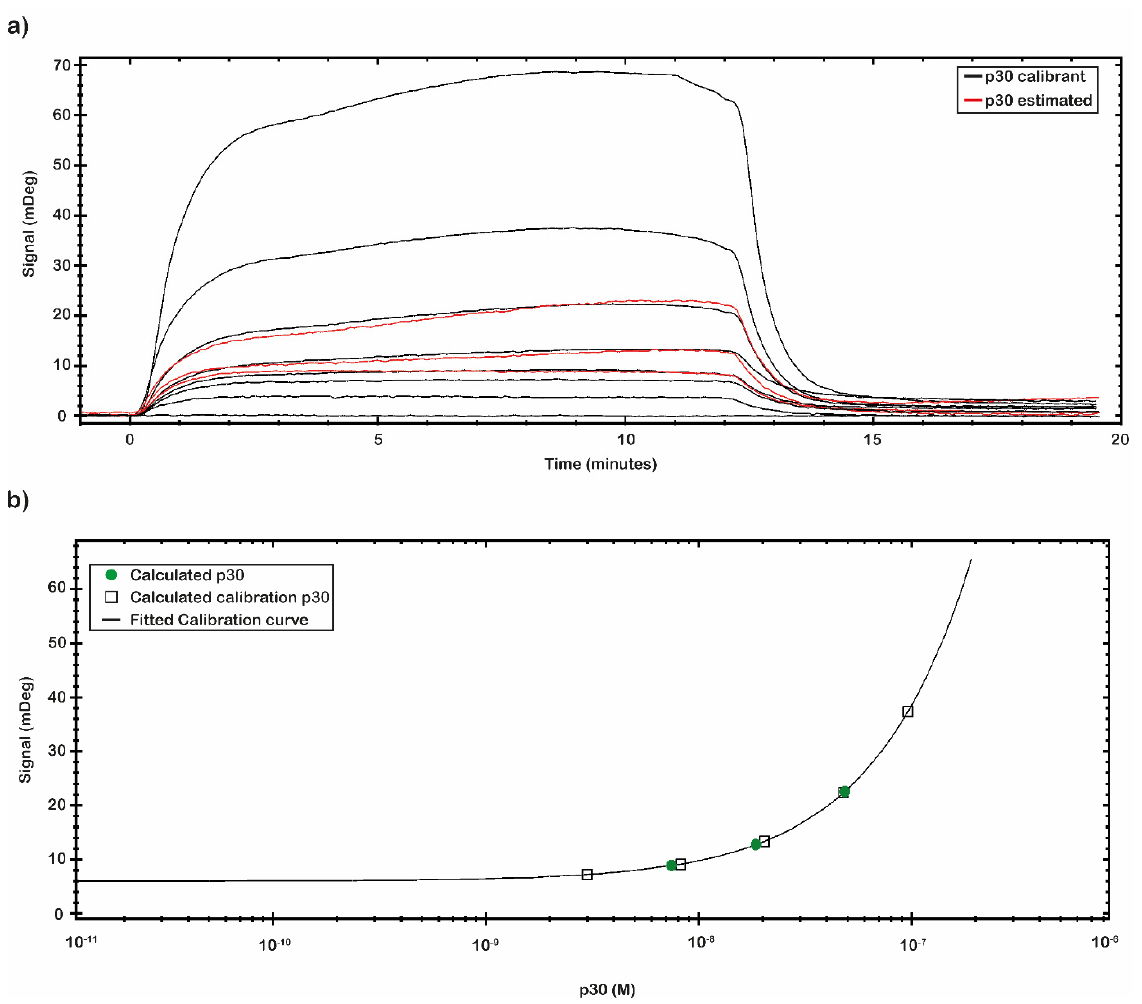
Figure 5. Concentration through calibration (CTC) analysis on p30 samples. ( a ) CTC analysis was performed with the recombinant antigens p30 in a nanomolar range from 0.01 to 200 nM (black line) that was used as calibrant, while another set of p30 samples was estimated (red line). All measurements were performed in 10 mM NaP pH 7.4 buffer at room temperature. ( b ) The mDeg values were plotted against the p30 calibrant sample concentration (black square) and fitted by a Four Parameter Eq Lo-Hi model. The obtained calibration curve (black line) was used to estimate the concentration of the second set of p30 analyzed samples (green circle). Table 2. Kinetic analysis results of the complex